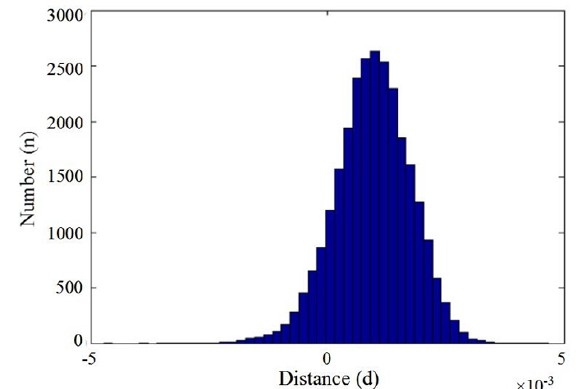
Figure 8. The statistical histogram of point cloud distribution on road